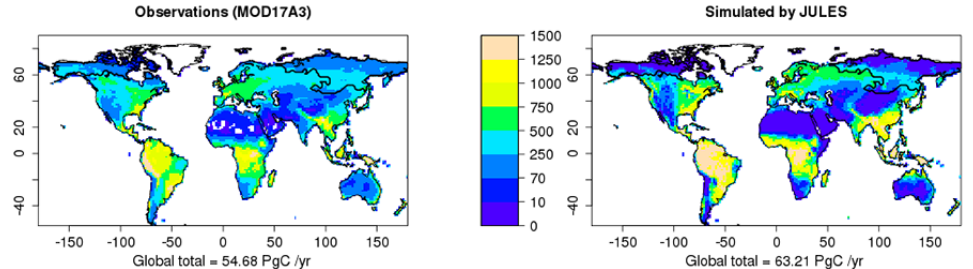
Figure 3. MODIS observed and JULES simulated multiannual mean net primary productivity in gCm − 2 year − 1 for the period 2000–2012. The black contours highlight the region where JULES simulates permafrost.